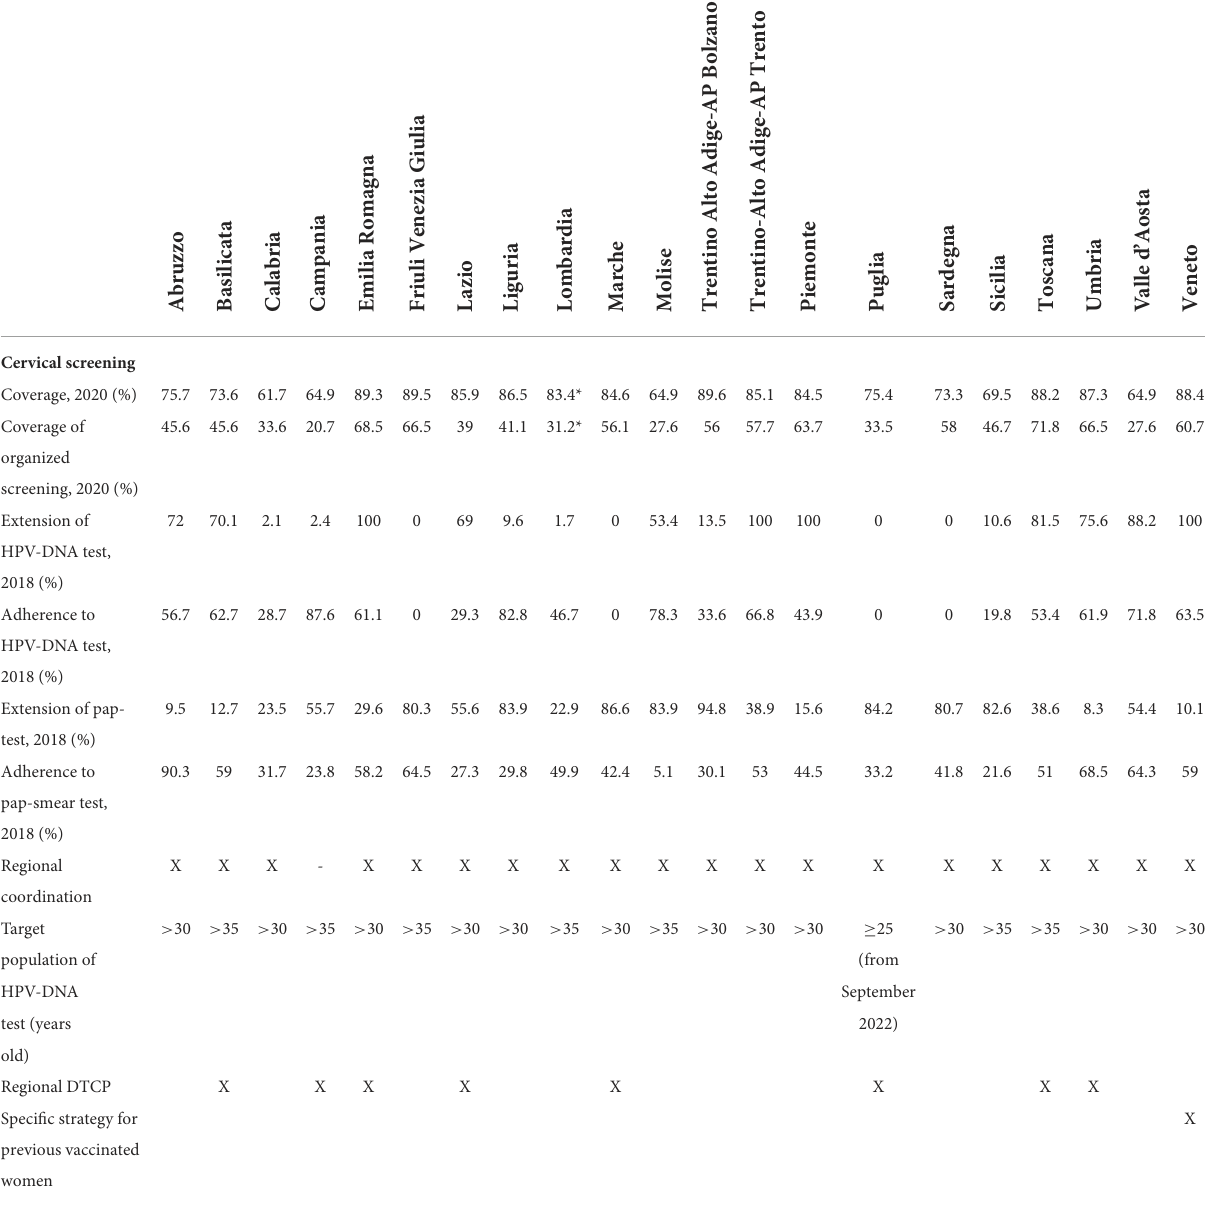
TABLE 3 Summary of information and data on cervical screening policies and strategies in the Italian